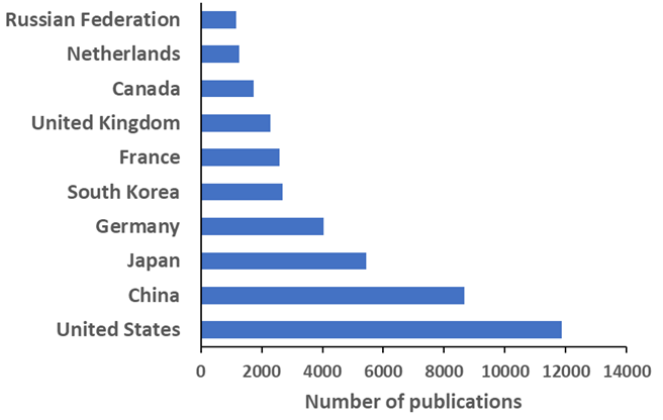
Figure 4. Top 10 countries by number of scientific publications on block copolymers.